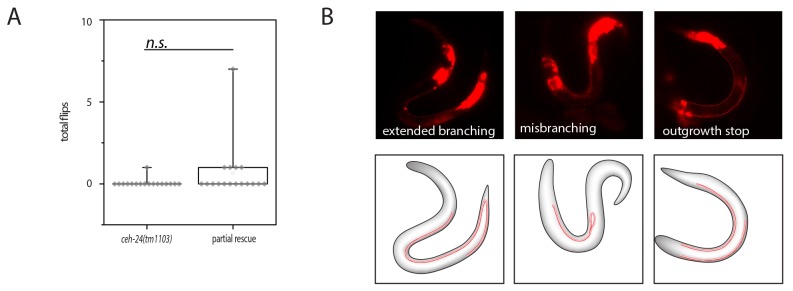
Lack of rescue of ceh-24(-) using ceh-24(+) driven by the ceh-17 promoter.(A) Quantification of flipping in ceh-24(tm1103) and ceh-24(tm1103); Ex[pceh-17::ceh-24::SL2mKate2]. (B) Fluorescence images of outgrowth defects in ceh-24(tm1103); Ex[pceh-17::ceh-24::SL2mKate2].